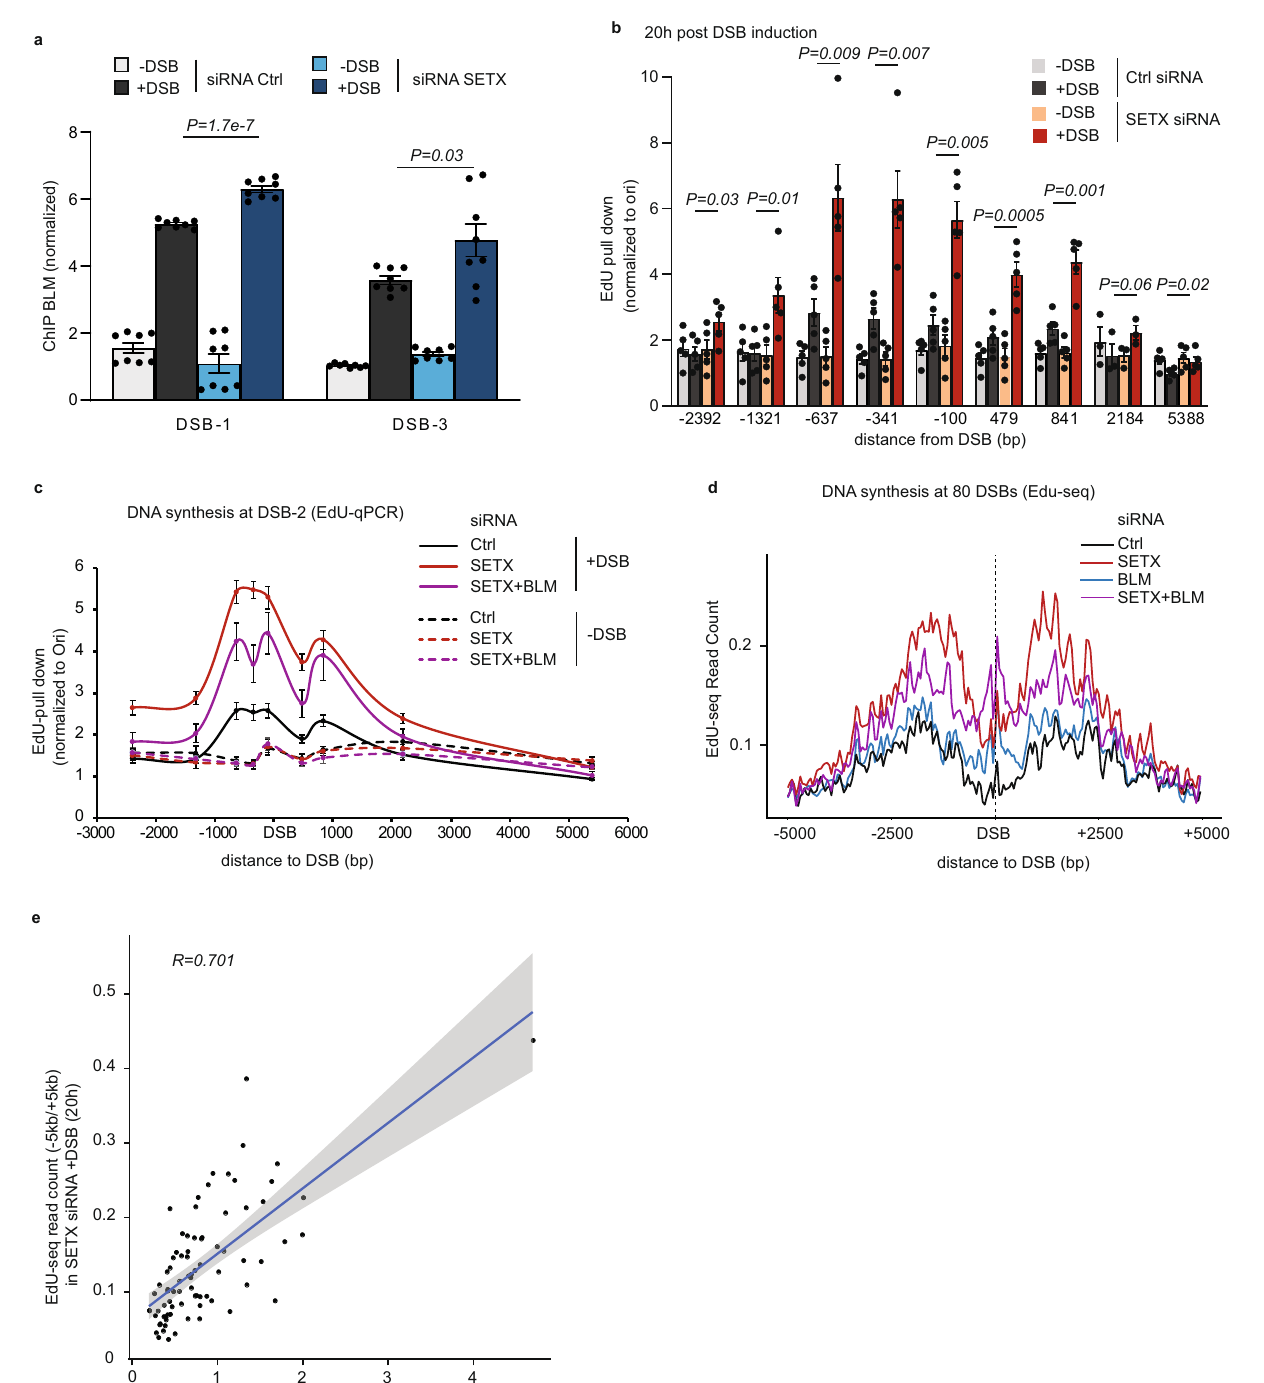
DNA synthesis at 80